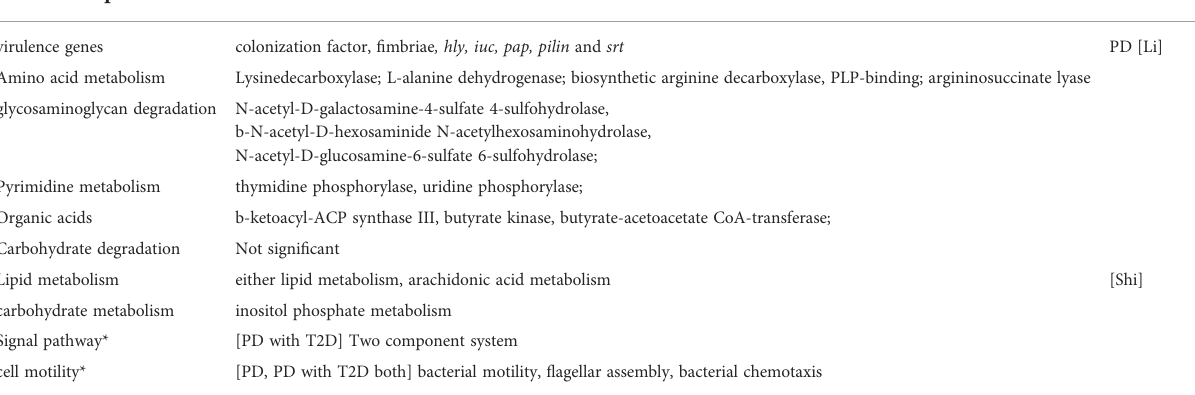
TABLE 1 The functional potentials in PD and PD with T2D communities. Functional